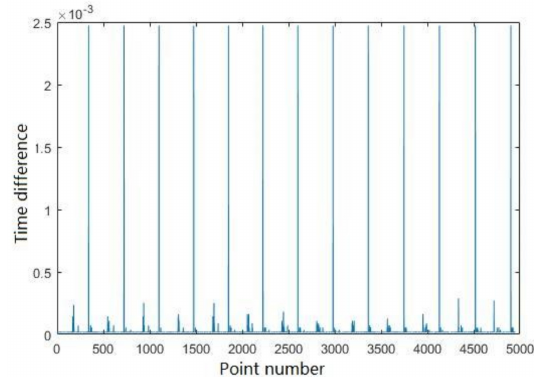
Figure 16. The time differences between neighbour points related to time attributes.